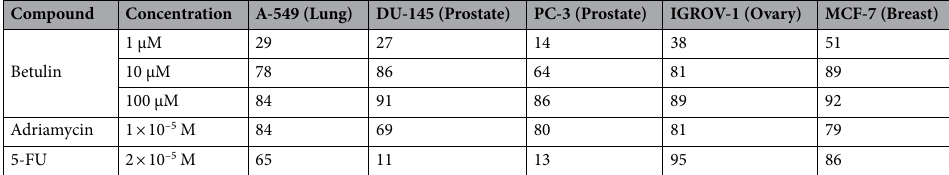
Table 3. In vitro cytotoxicity activities of betulin against different human cell lines.